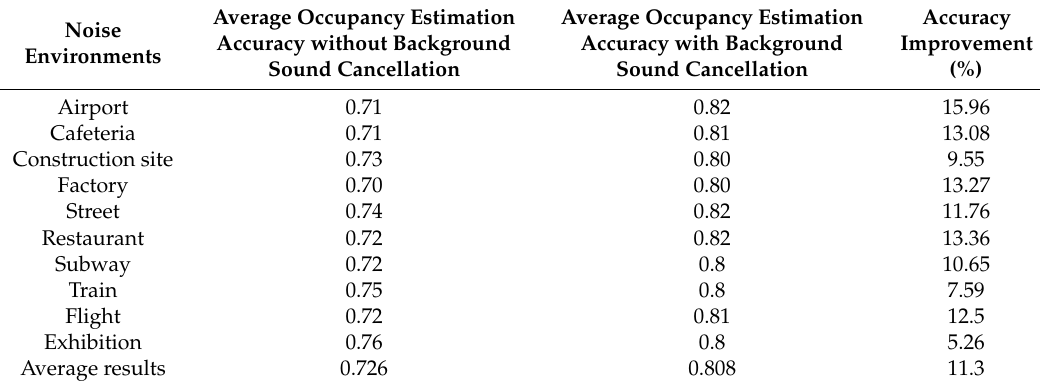
Table 2. Comparison of occupancy estimation accuracy before and after applying background sound cancellation algorithm, assuming 65 dB background sound and 60 dB human speech.